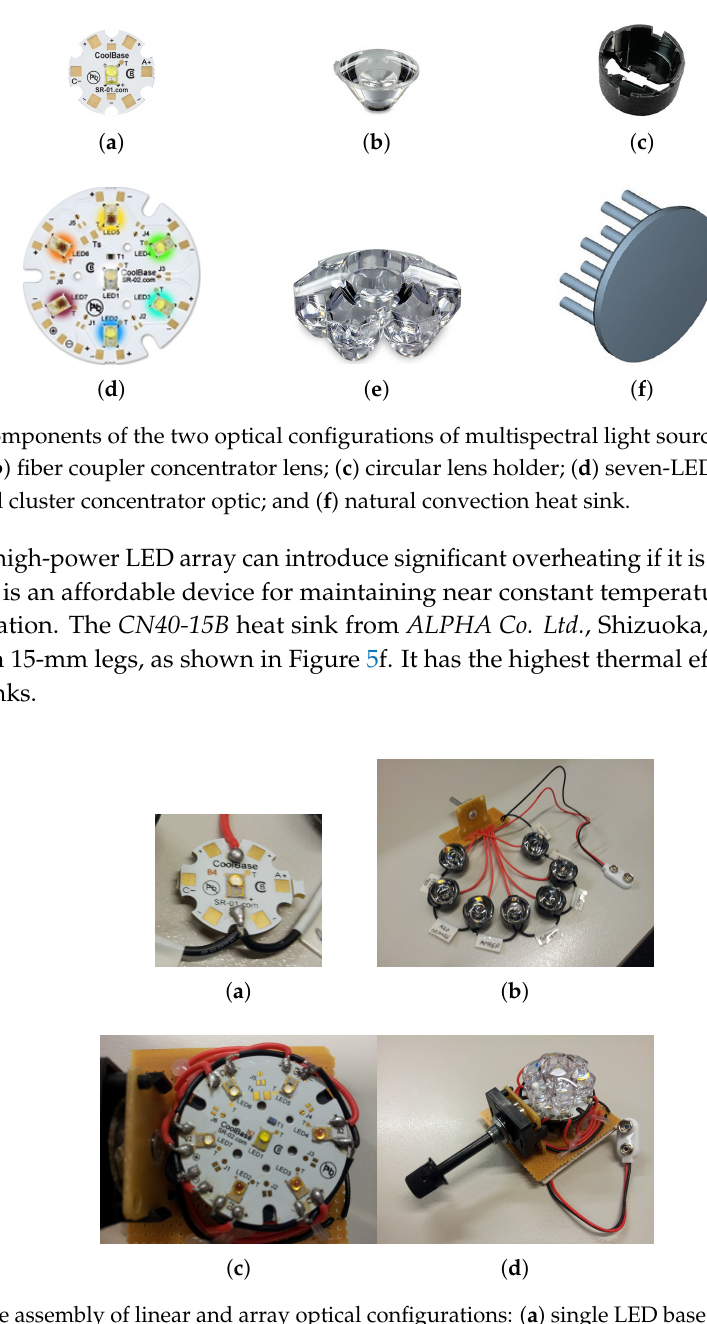
Figure 6. The assembly of linear and array optical configurations: ( a ) single LED base with connections to switch; ( b ) patched assemblies with fiber beam lens in linear configuration; ( c ) array LED base with connections to switch; and ( d ) patched assembly with cluster concentrator lens in array